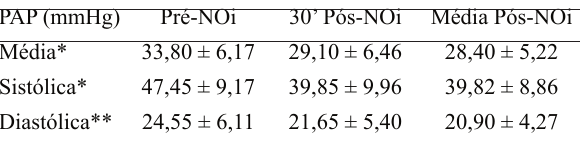
Tabela 3. Resultados da Variável